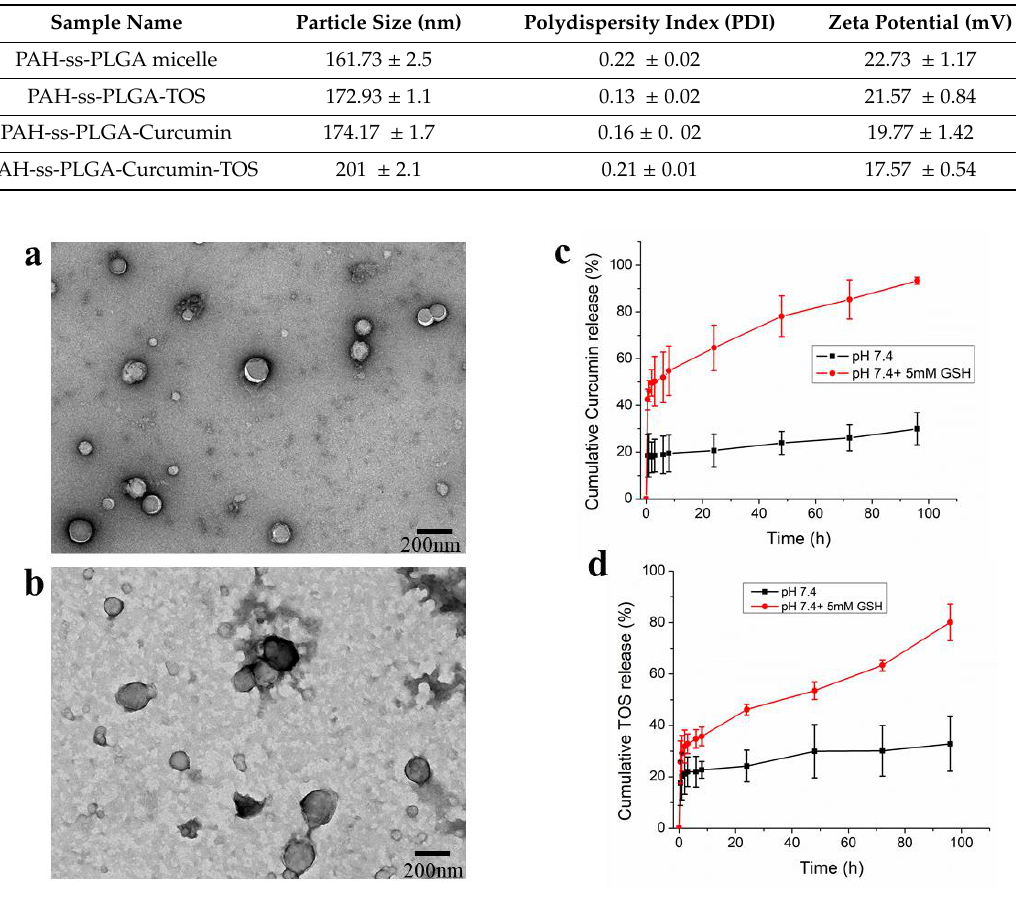
Figure 3. TEM image of PAH-SS-PLGA-micelle in the absence ( a ) and presence of 5 mM GSH ( b ), in vitro curcumin ( c ) and TOS ( d ) release from PAH-SS-PLGA micelle in the presence and absence of GSH (5 mM). Data are expressed as mean ± SD values ( n = 3).